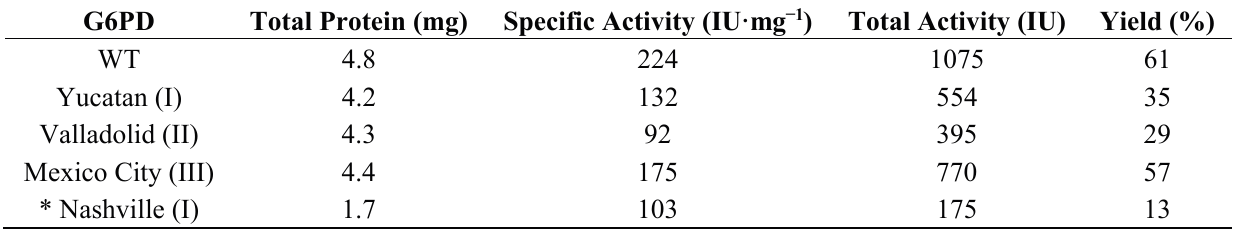
Table 1. Summary of the purification of recombinant human G6PD enzymes.